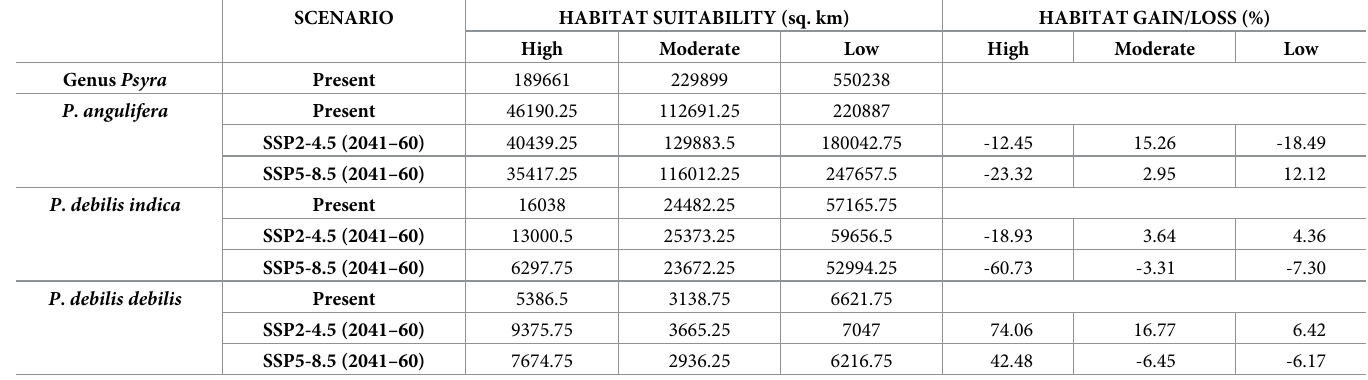
Table 3. The predicted suitable area (high, moderate and low) of the genus Psyra and selected taxa under the current climatic condition with respective area gain or loss in the year 2041–60 under two future climatic scenarios SSP2-4.5 and